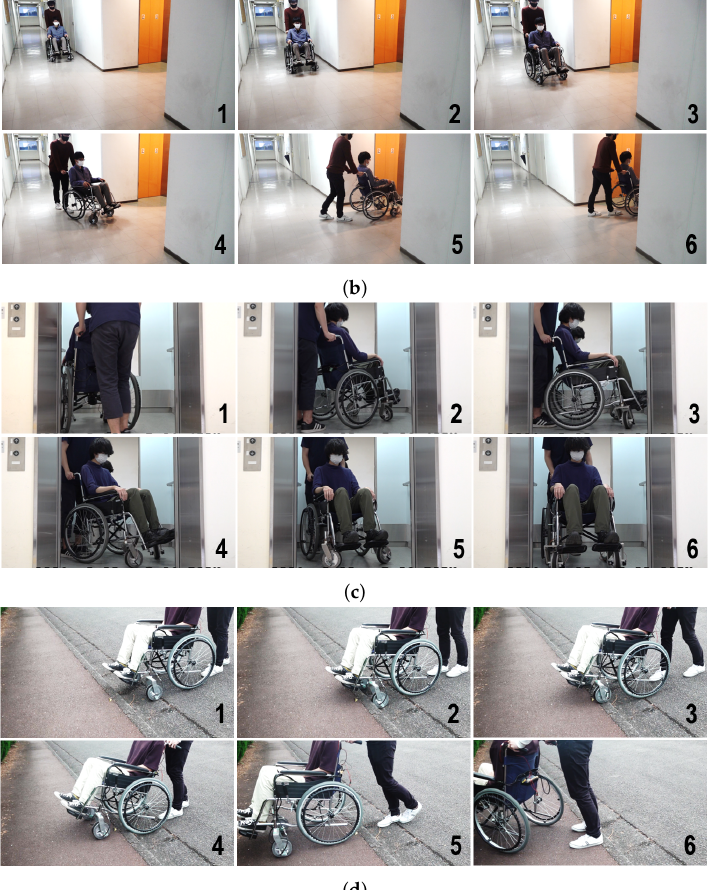
Figure 24. Experimental scenes for a self-propelled wheelchair with the proposed wheel under the environmental conditions of daily lives. ( a ) Straight-line motions; ( b ) rotation motions in a hallway with a corner; ( c ) rotation motions in an elevator; ( d ) step-ascending